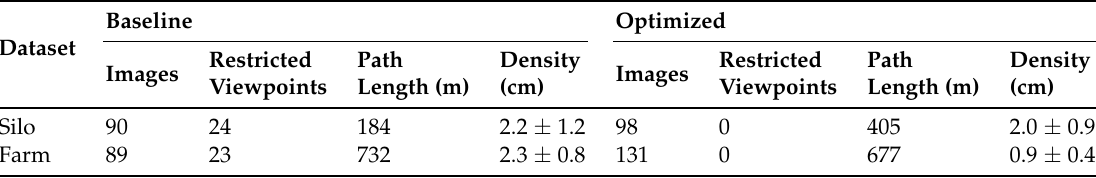
Table 4. Comparing automatic and semantically-aware trajectories toward established baseline trajectories for the real world experiments including the number of acquired images, the number of acquisition viewpoints above restricted areas, the path length, and the average distance and standard deviation of adjacent 3D points after generating a dense 3D point cloud from the acquired images. More details about the generation of the baseline trajectories are given in Sections 4.2.1 and